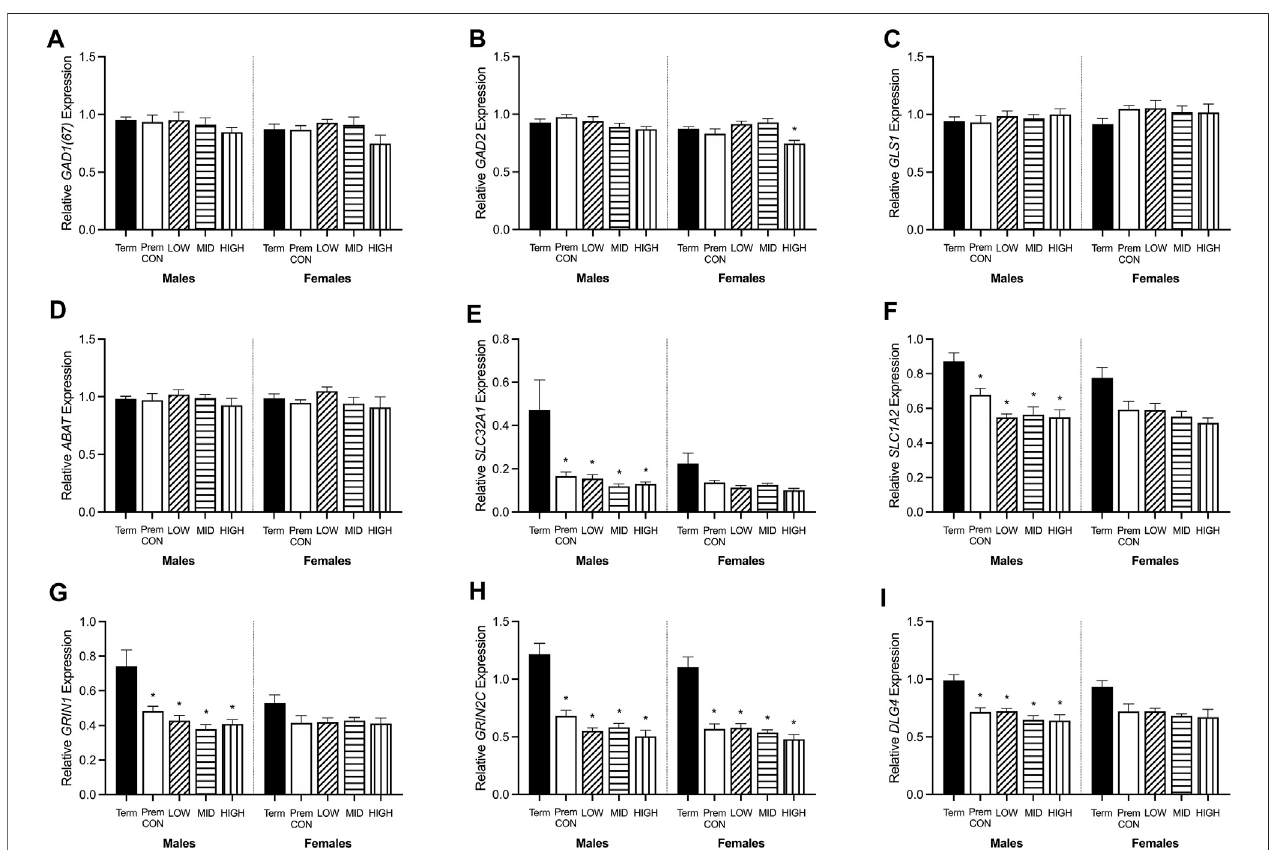
FIGURE5| RelativemRNAexpressionforGABAandglutamatergicmarkersinthehippocampusoftermcontrol(black;males n =8,females n =7),pretermcontrol (white;males n =7,females n =6),low-GNX(diagonalstripes;males n =5,females n =6),mid-GNX(horizontalstripes;males n =6,females n =6),andhigh-GNX(vertical stripes; males n =6, females n =6). (A) GAD(67) , (B) GAD2 , (C) GLS1 , (D) ABAT , (E) SLC32A1 , (F) SLC1A2 , (G) GRIN1 , (H) GRIN2C , and (I) DLG4 . Datapresented as means ± SEM with * indicating signi fi cance at p < 0.05.